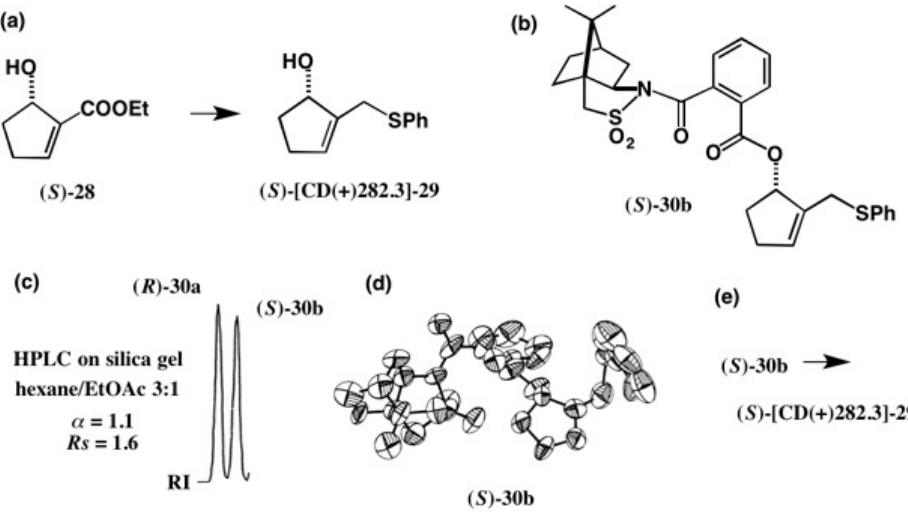
Figure 19. Preparation ( a , b ) and HPLC separation ( c ) of esters 30a and 30b , and the AC determination of ester ( S )- 30b by X-ray analysis ( d ). From ester ( S )- 30b , alcohol ( S )-[CD(+)282.3]- 29 was obtained ( e ). HPLC, redrawn from [32]. ORTEP drawing, reprinted from [31].